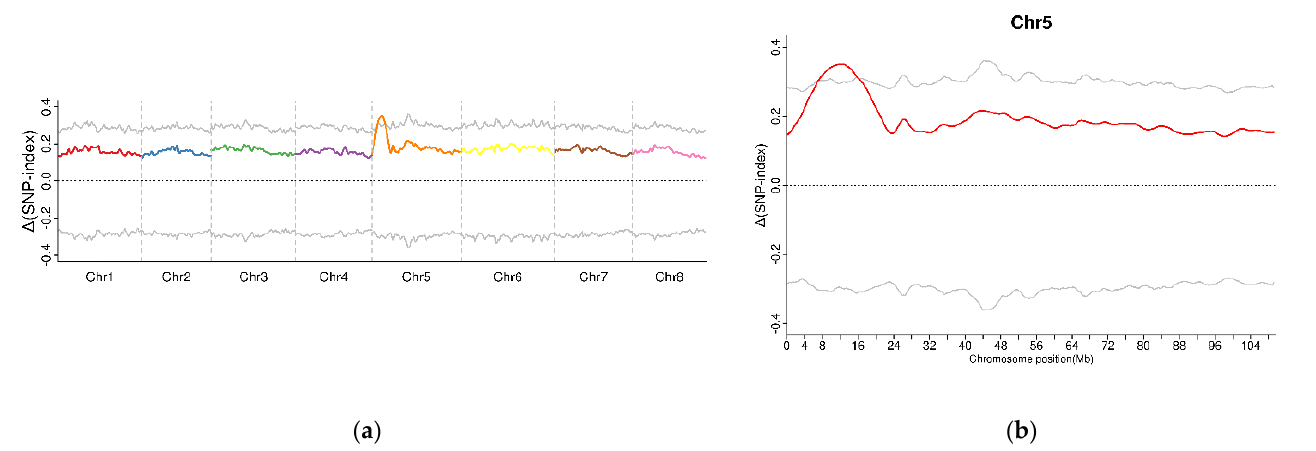
Figure 2. The calculation of Δ (SNP-index) values on the chromosome to identify the candidate regions associated with male sterility in alfalfa based on BSA-seq. ( a ). Candidate regions were located by the association analysis of specific SNPs between T03 and T04. ( b ). The specific candidate region on chromosome 5. Table 2. Candidate genomic regions identified by association analysis of BSA-seq.